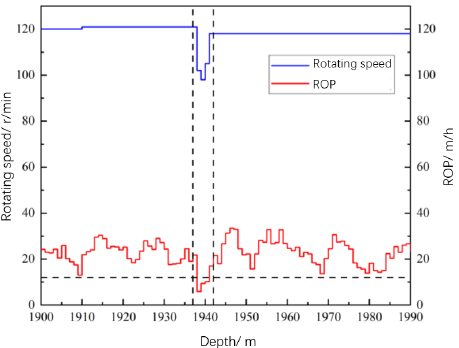
Figure 5. The relationship between ROP and rotation speed in Well X-2.